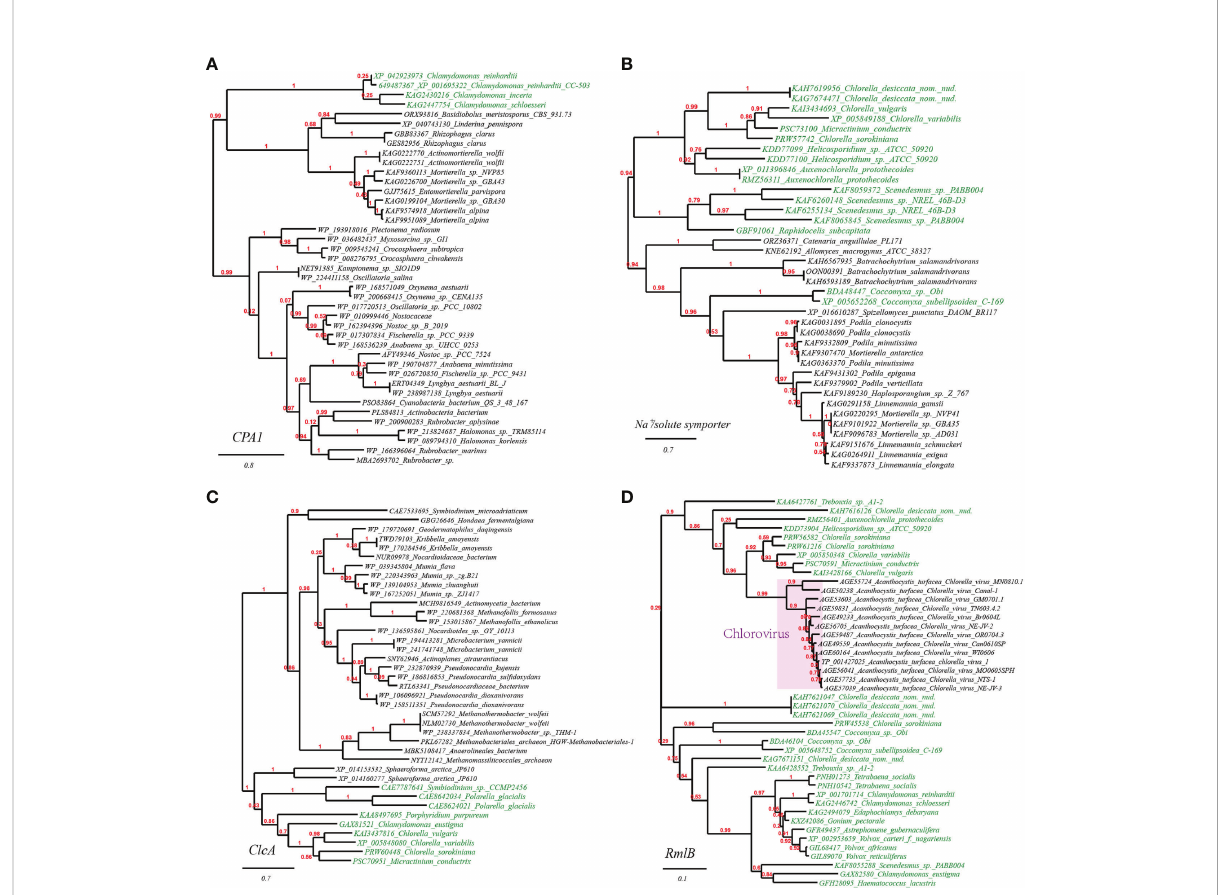
FIGURE 2 Phylogenetic tree of osmotic and drought stress resistance proteins in plant genomes originated from microbial taxa. The phylogeny construction was conducted based on gene-translating protein sequences using PhyML program with the Maximum Likelihood (ML) method and 1,000 bootstrap replicates (with bootstrap values in red showing on respective branches). Branches leading to plant taxa are marked by green color, whereas those belonging to microbial lineages are in black. (A) sodium/proton antiporter (CPA1); (B) Na + /solute